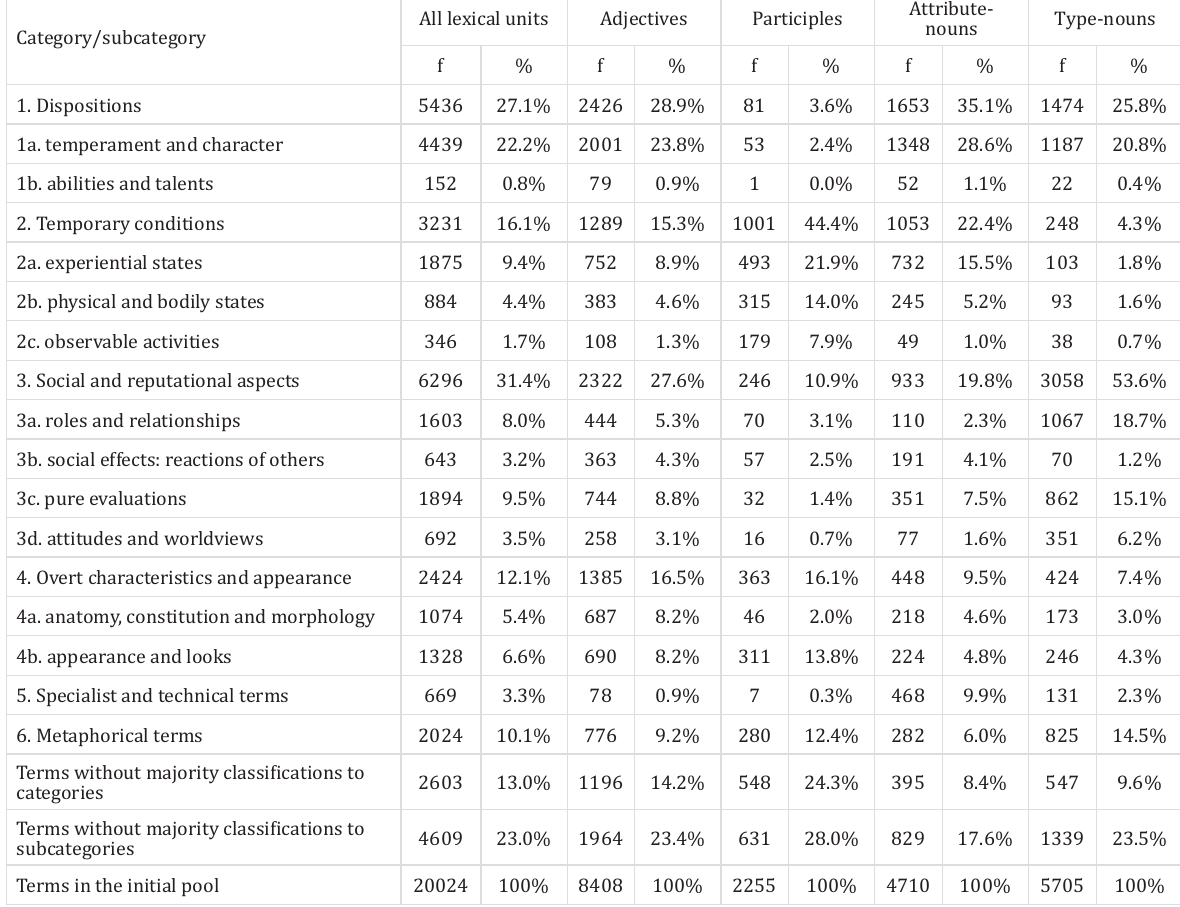
Table 2. Results of Psycholexical Taxonomy of Person-Descriptive Terms Belonging to Four Categories of Lexical Units